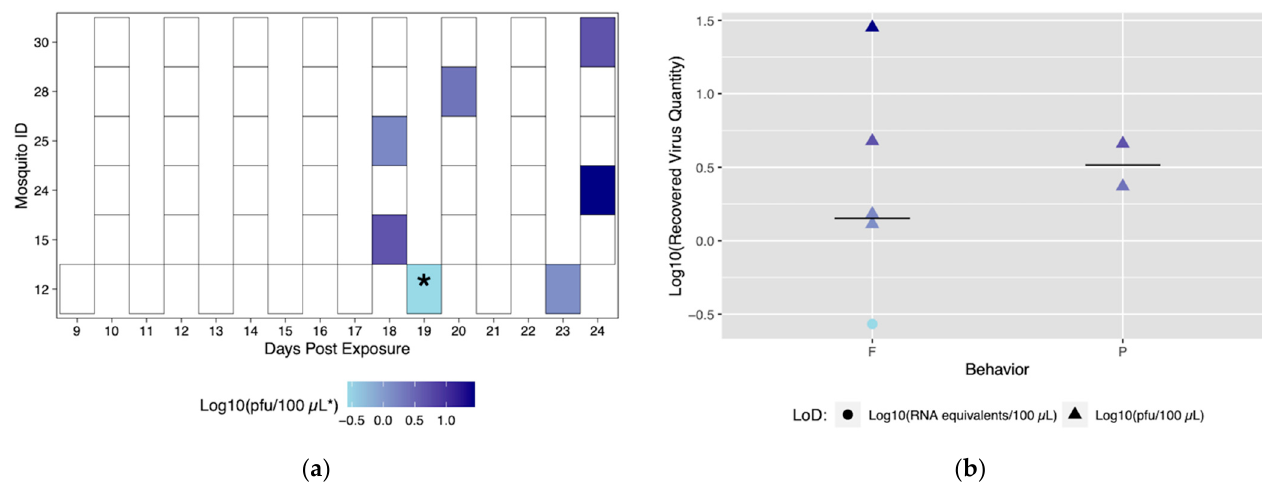
Figure 6. Viral titers expectorated with each successful transmission event by field-derived individuals. Only mosquitoes which had successful transmission over time are shown. A successful transmission event is defined by both a positive serum sample via qRT-PCR and growth on Vero cells. ( a ) Each shaded square represents a transmission event, with white squares representing no detectable virus. Other squares are scored from lowest viral titer (light blue) to highest viral titer (navy). ( b ) Viral titers present in serum were compared for blood fed (F) vs. probed (P). Viral titers range from lowest detectable titer (light blue) to highest detectable titer (navy). Asterisks (*) indicate where recovered quantity is below the limit of detection from our sensitivity analysis and reflect qRT-PCR values of genome equivalents (viral RNA copies/100 µ L) rather than pfu/100 µ